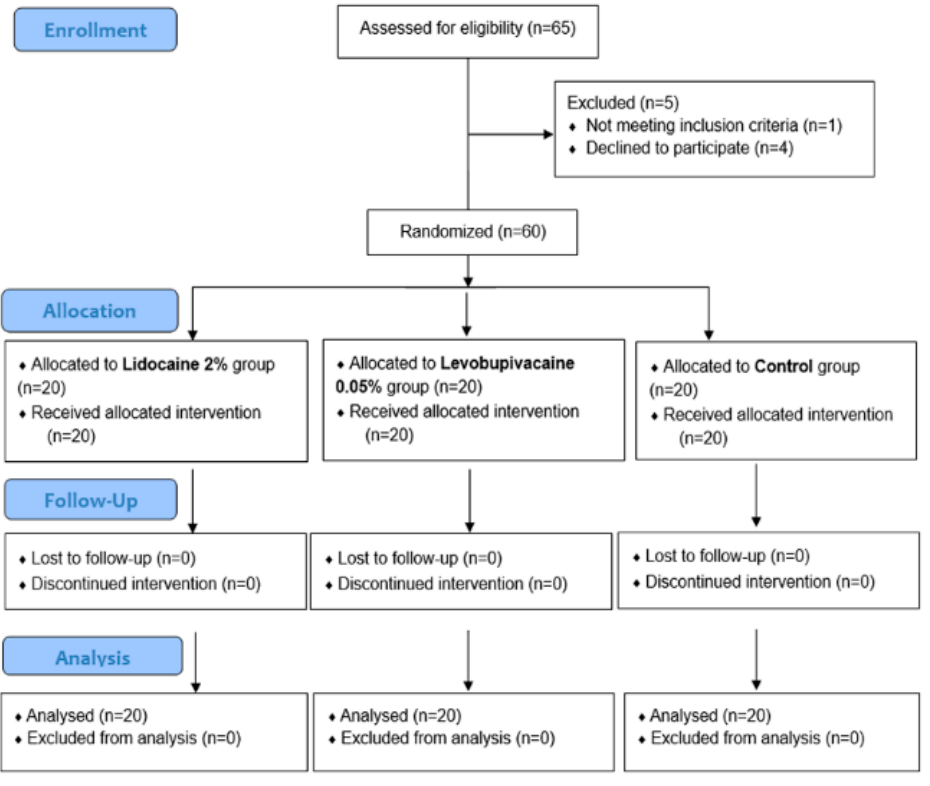
Figure 1. Flow chart of the study .